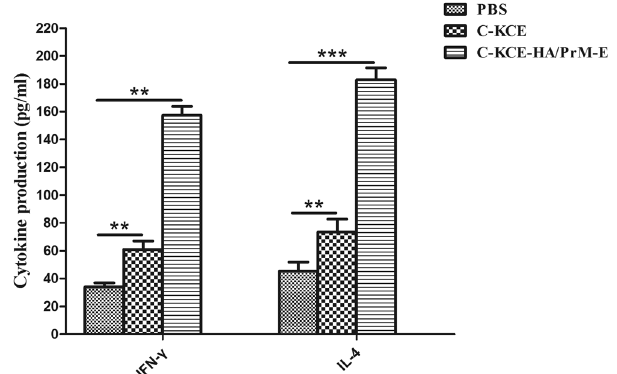
Figure 5. Serum IFN- γ and IL-4 cytokine levels in ducks. Ducks were vaccinated with PBS, 10 5 PFU of C-KCE or C-KCE-HA/PrM-E (n = 3 per group) subcutaneously. On the day of final immunization (day 14), the serum levels of Th1-type cytokine (IFN- γ ) and Th2-type cytokine (IL-4) in ducks were determined by ELISA. Data are shown as the mean ± SD. ** P < 0.01, *** P < 0.001.